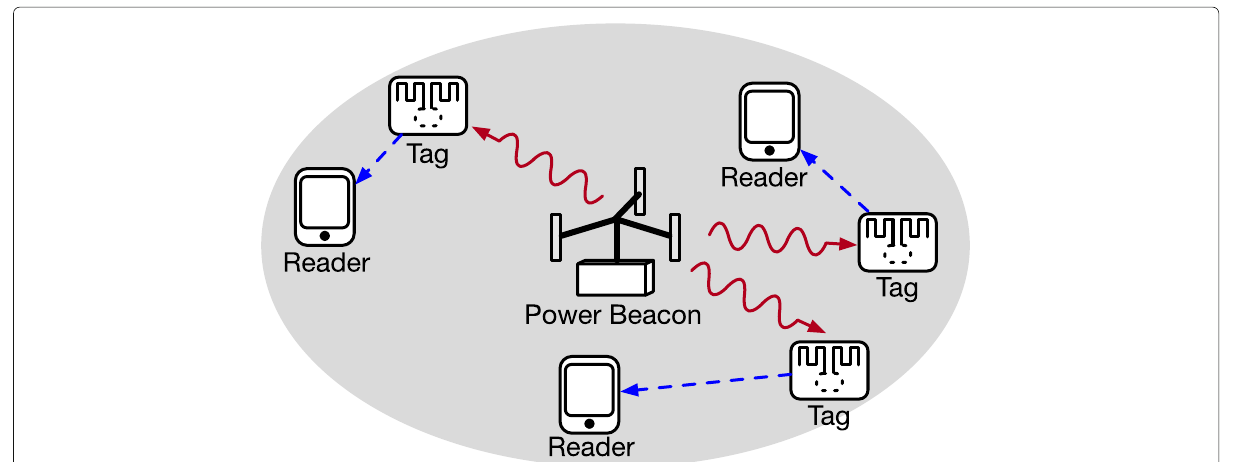
Fig. 7 Wirelessly powered